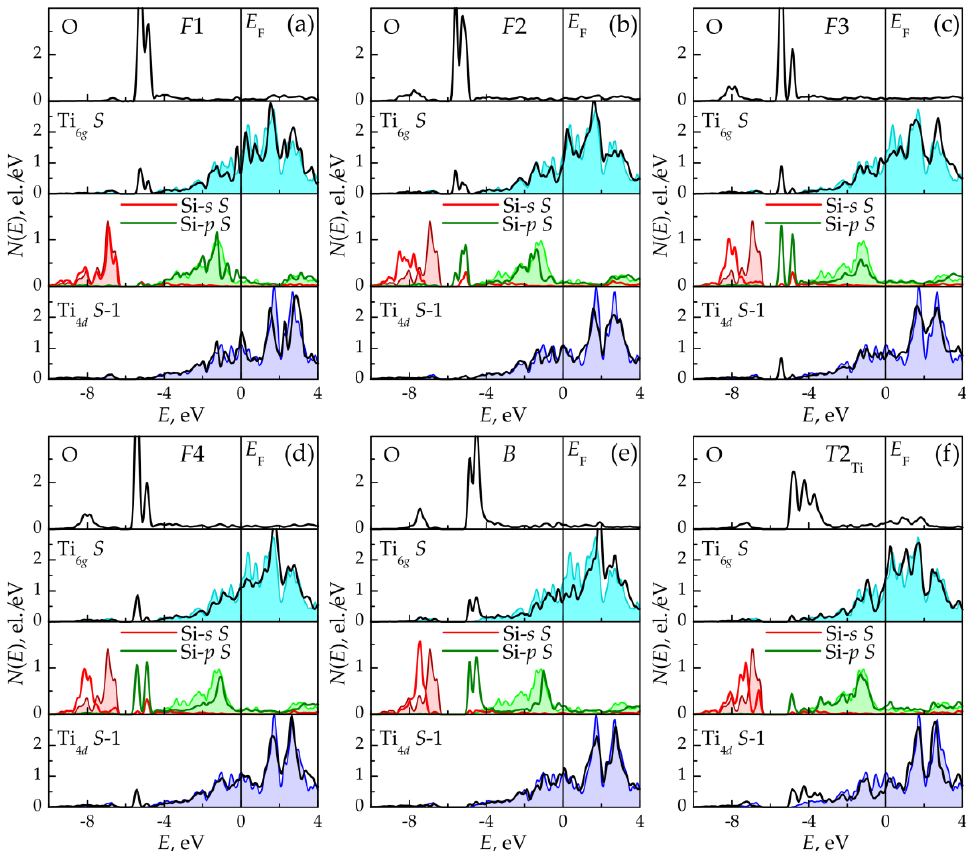
Figure 6. Local DOS of oxygen and the nearest atoms of the surface ( S ) and subsurface ( S − 1) layers for all positions: ( a ) F 1, ( b ) F 2, ( c ) F 3, ( d ) F 4, ( e ) B and ( f ) T 2 Ti . Local DOS of Ti and Si atoms on the clean surface are shown in color fill.